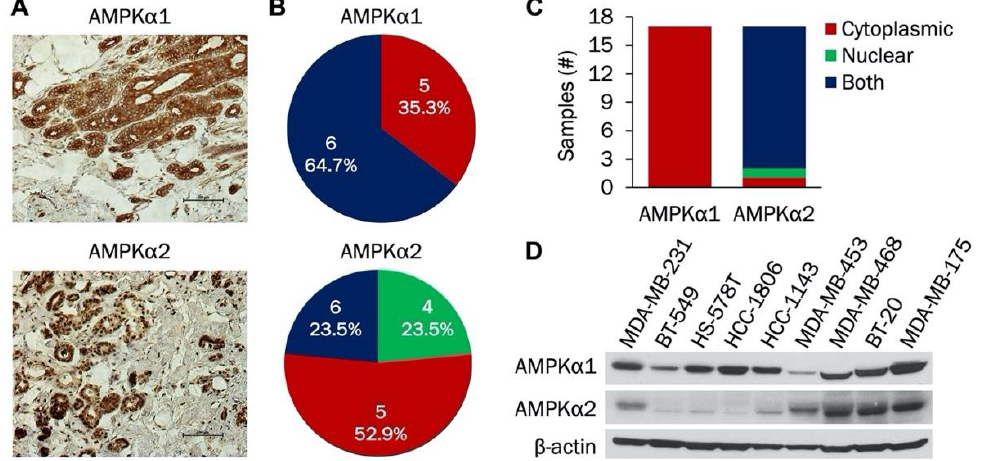
Figure 1. Analysis of AMPK α 1 and AMPK α 2 expression in triple negative breast cancer (TNBC) whole tissue sections and established cell lines. ( A ) Representative immunohistochemical staining of AMPK α 1 and AMPK α 2 in TNBC whole tissue sections. ( B ) Scoring distribution of AMPK α 1 and AMPK α 2 in TNBC whole tissue sections ( n = 17). ( C ) Subcellular localization (nuclear, cytoplasmic, or both) of AMPK α 1 and AMPK α 2 in TNBC whole tissue sections ( n = 17). ( D ) Western blot of AMPK α 1 and AMPK α 2 expression in a panel of established TNBC cell lines ( n = 9).